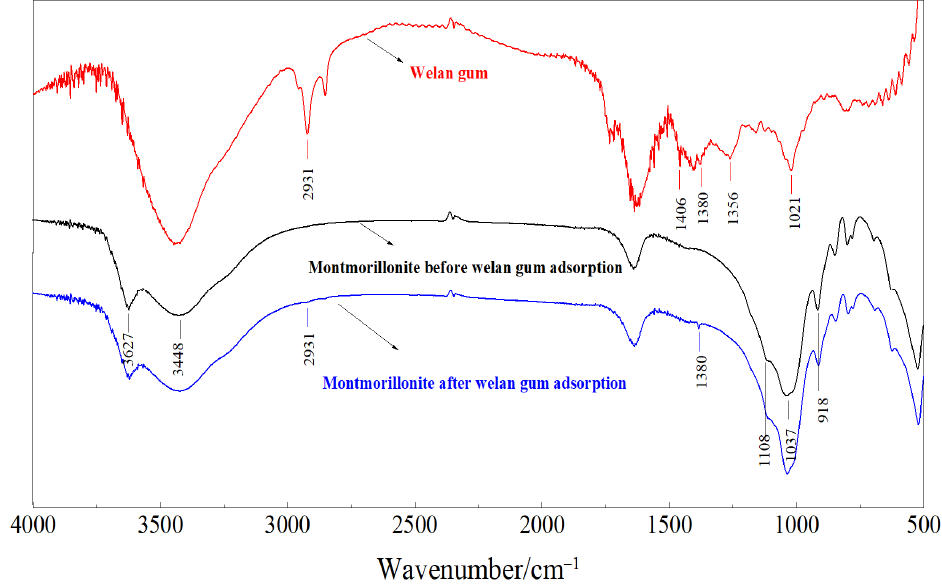
Figure 7. FT-IR spectra of welan gum and montmorillonite before and after welan gum adsorption.